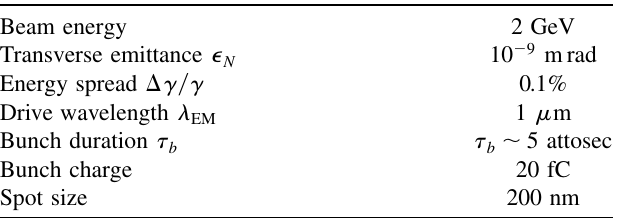
TABLE I. Electron beam parameters expected for structure- based laser-driven particle